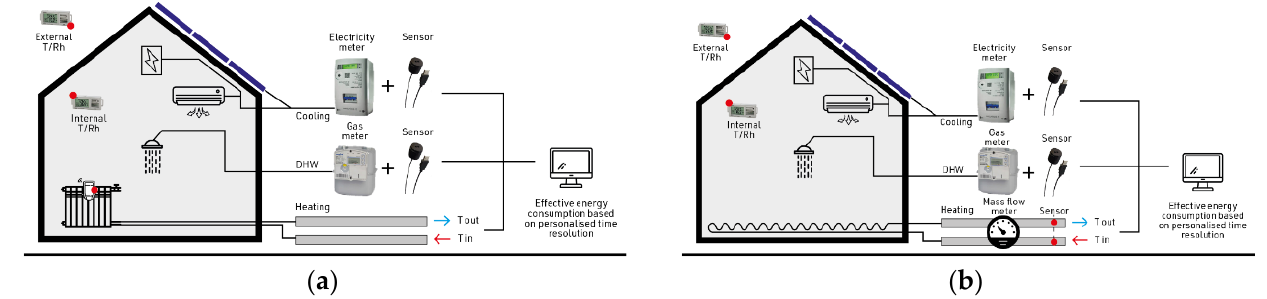
Figure 3. Advanced level: ( a ) Configuration 3a: dwelling with independent cooling system and do- mestic hot water production but centralized heating production (radiator system); ( b ) Configuration 3b: dwelling with independent cooling system and domestic hot water production but centralized heating production (heated floors system). Source: elaborated by authors.